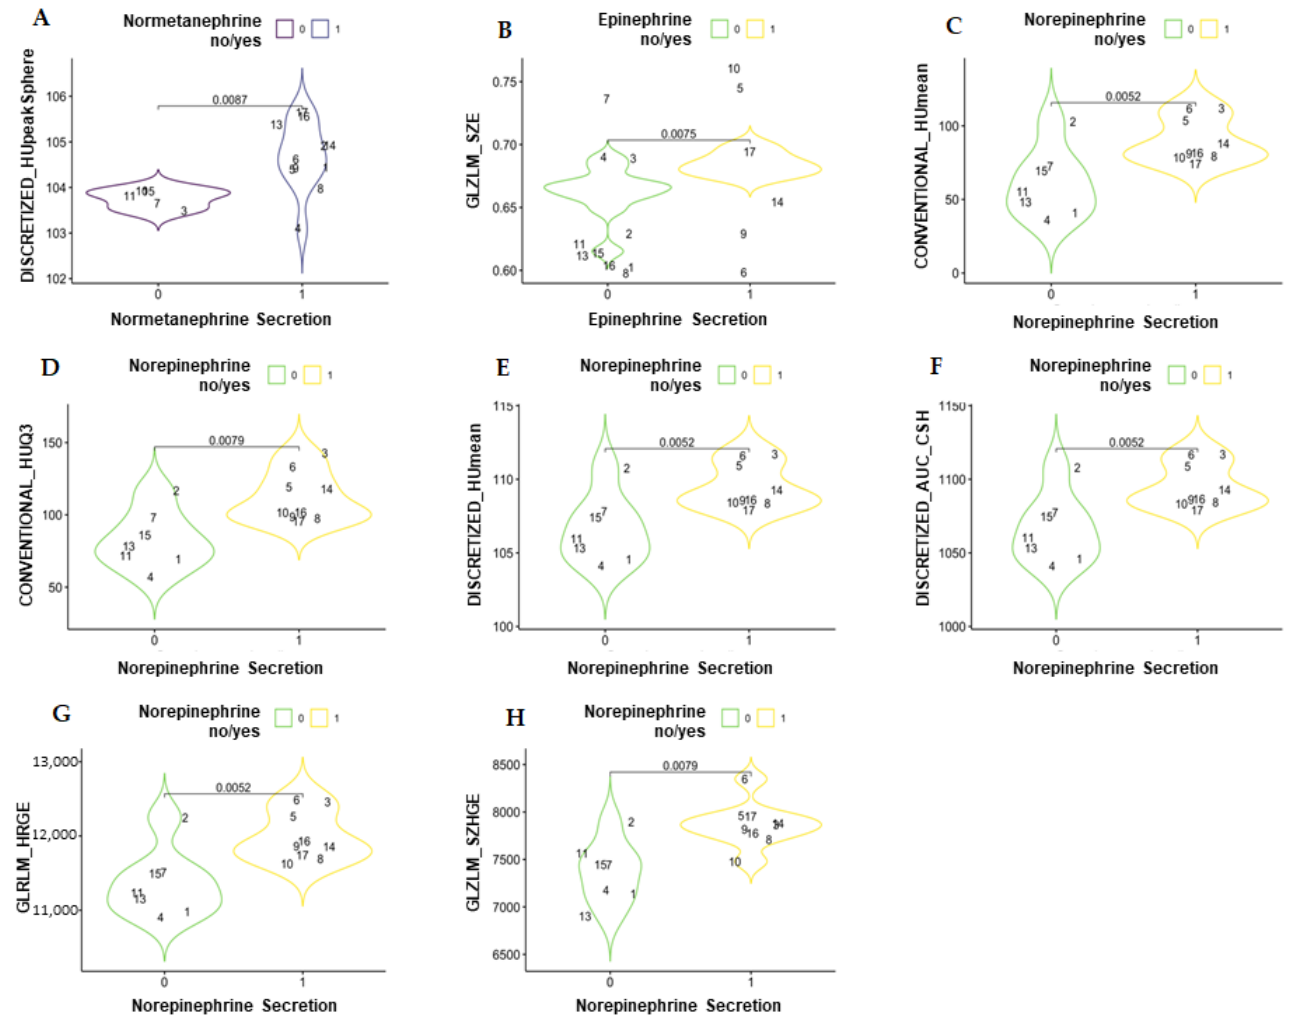
Figure 2. Violin plots showing the statistically significant differences in textural parameters between secreting and non-secreting pheochromocytomas in an unenhanced scan ( A ) and in venous scans ( B – H ). DISCRETIZED_HUpeak = discretized Hounsfield unit peak; GLZLM_GLNU = gray-level zone-length matrix–gray-level non-uniformity; GLZLM_SZE = gray-level zone length matrix–short-zone emphasis; CONVENTIONAL_HUmean = conventional Hounsfield unit mean; CONVENTIONAL_HUQ3 = conventional Hounsfield unit third quartile; DIS- CRETIZED_HUmean = discretized Hounsfield unit mean; DISCRETIZED_AUC_CSH = discretized area under the curve of the cumulative histogram; GLRLM_HGRE = gray-level run-length matrix– high gray-level run emphasis; GLZLM_SZHGE = gray-level zone length matrix–short-zone high gray-level emphasis. In the comparison between high and low PASS grading, GLZLM_GLNU (gray-level zone-length matrix–gray-level non-uniformity) in the unenhanced phase and GLRLM_GLNU (gray-level run-length matrix–gray-level non-uniformity) and GLRLM_RLNU (gray-level run-length matrix–run-length non-uniformity) in the venous phase showed a statistically significant difference between the groups (Figure 3 and Supplementary Table in the repos- itory data: https://doi.org/10.25430/researchdata.cab.unipd.it.00000741, accessed on 25 December 2022). The results were calculated in all three phases (unenhanced, arte- rial, and venous) and are completely reported in the Supplementary Material available in